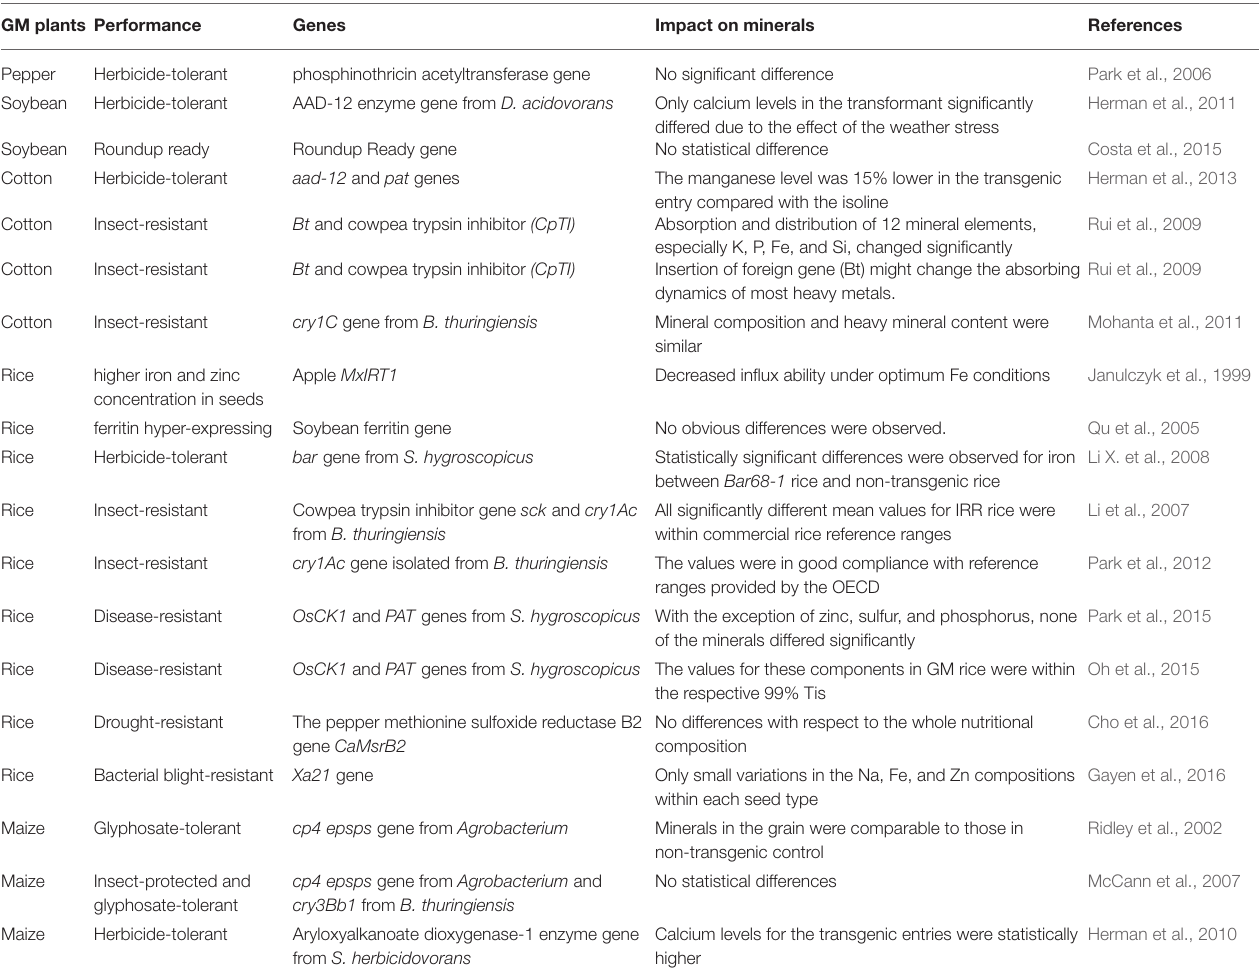
TABLE 2 | Transgenes and their impact on